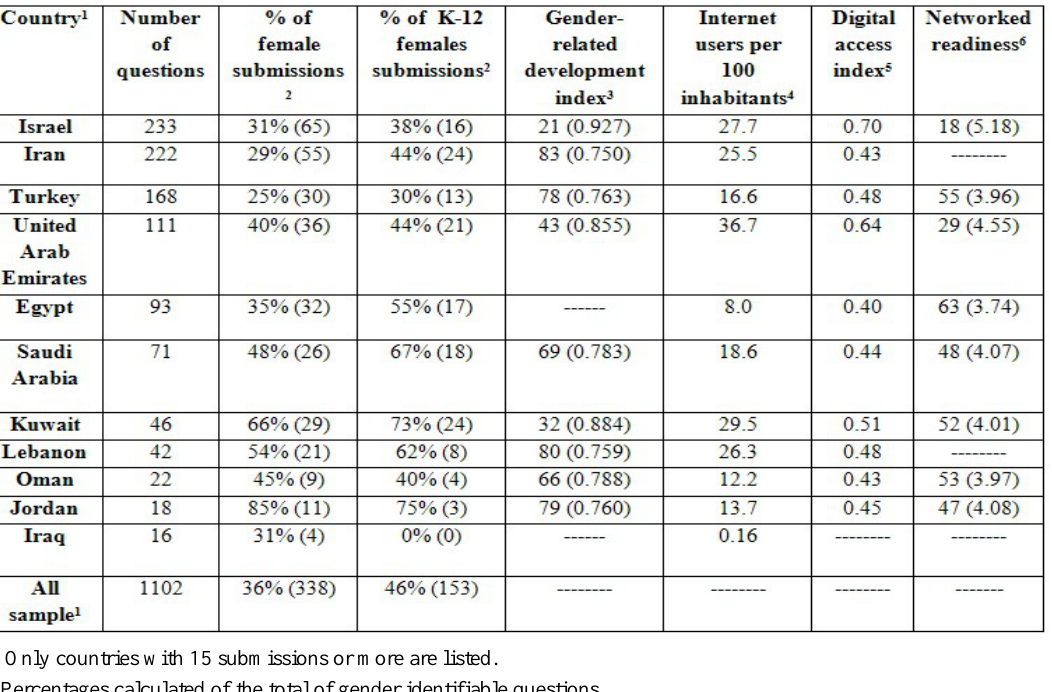
Country Characteristics with Regard to General and Female Participation, Gender Equity,